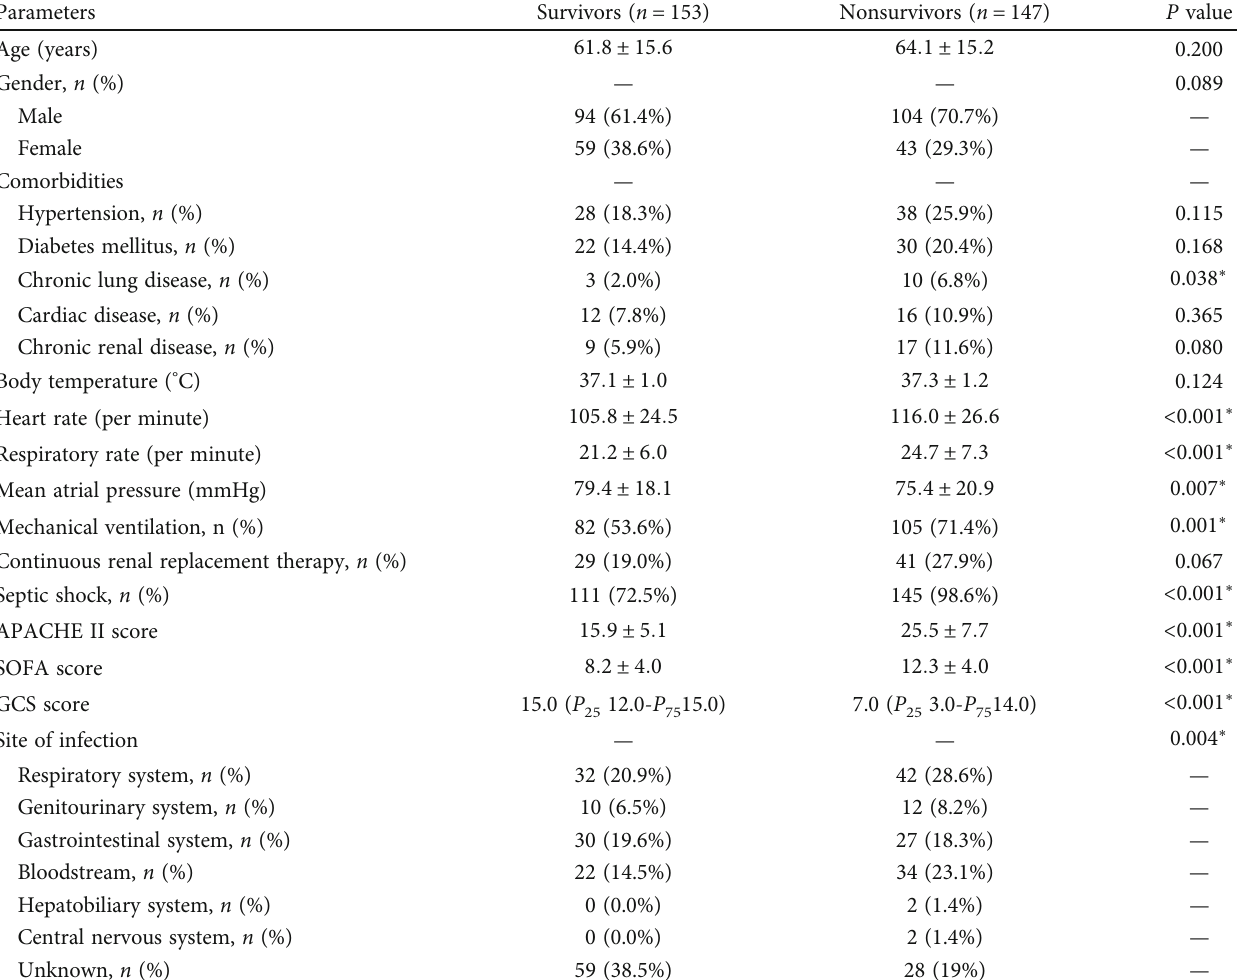
Table 1: Baseline characteristics of patients with sepsis between the survivor and non-survivor